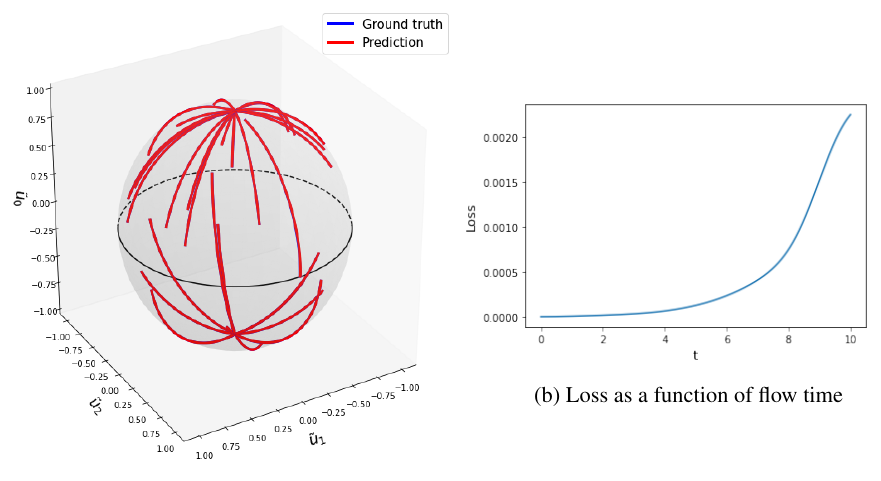
(a) Ground truth and predicted trajectories Figure 4: Results of our extrapolation up to τ = 10 based on training up to τ = 1. (a) Extrapolated evolution of 30 samples. The ground truth and the prediction are very close. (b) Loss function as a function of flow time. At large times the loss increases by up to three orders of magnitude compared to the original interval τ ∈ [0 ,